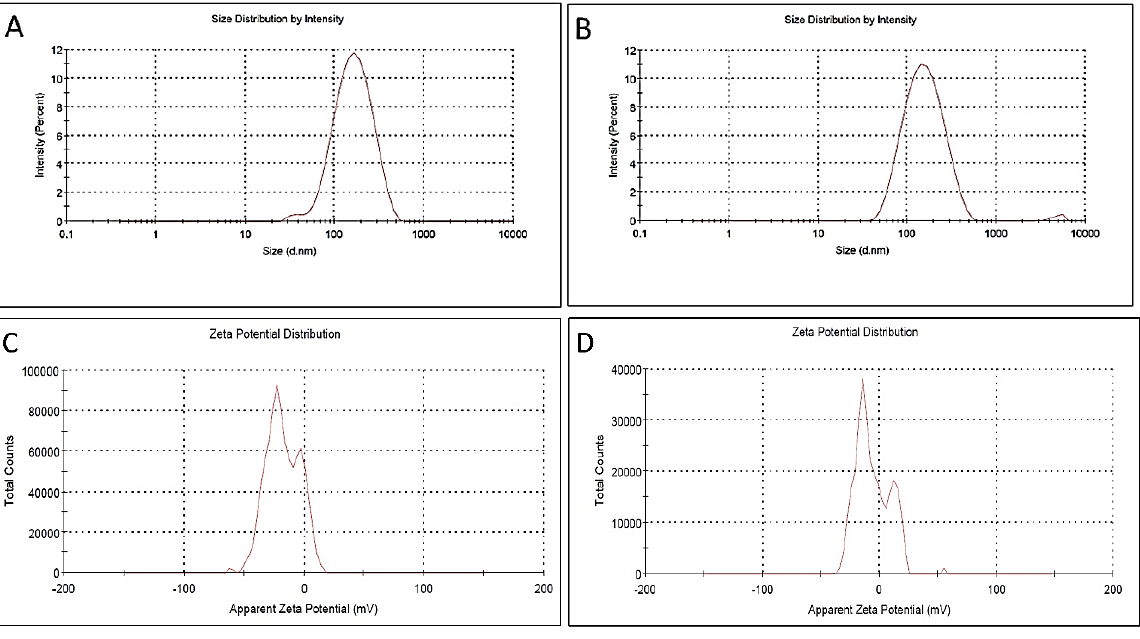
Figure 4. Zeta potential measurements of the biosynthesized silver nanoparticles using the extracts, AngTE and AnsTE; ( A , B ): particles size distribution of Ang-AgNPs and Ans-AgNPs, respectively, ( C , D ): particles charges of Ang-AgNPs and Ans-AgNPs, respectively.